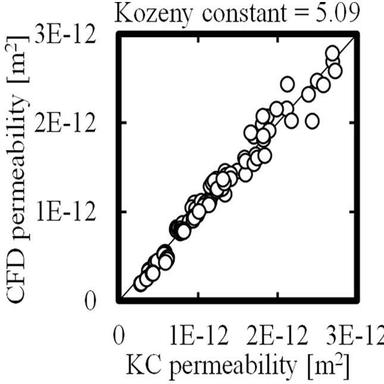
Comparison of permeabilities estimated by the CFD simulation and the KC equation. The Kozeny constant, which is shown above the plot, was obtained by fitting.